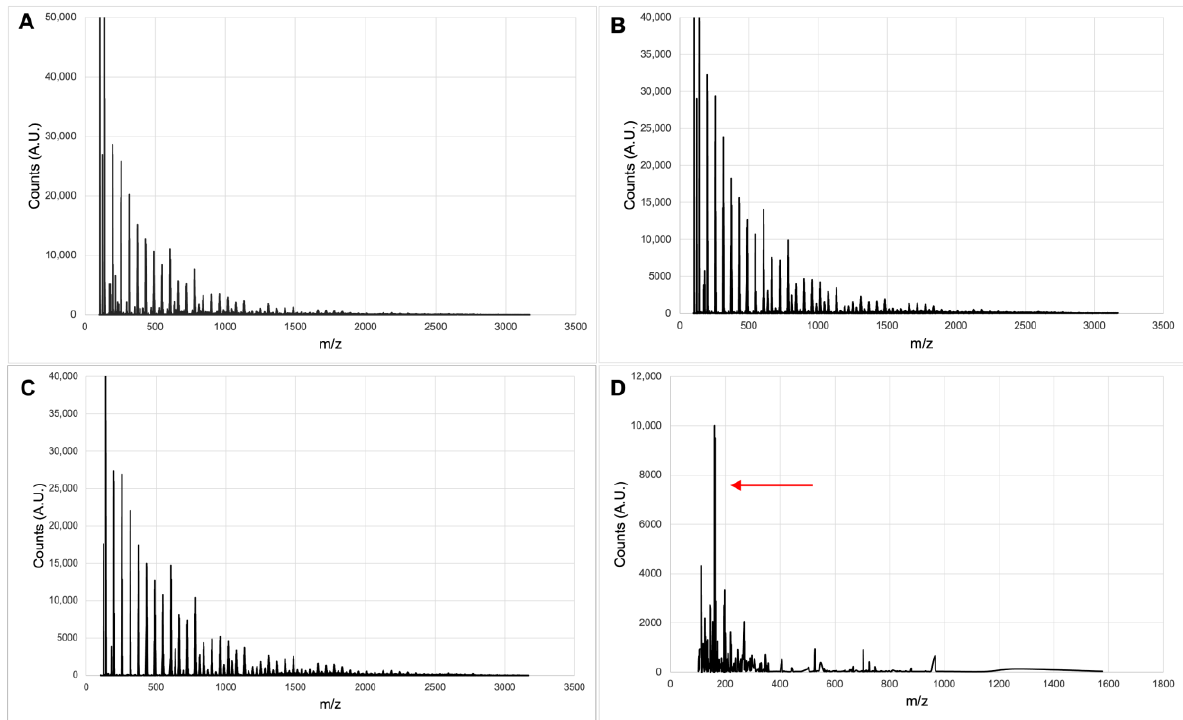
Figure 5. Electrospray ionization mass spectrometry of alginate samples digested with ( A ) 1 M HCl for 3 h, ( B ) 2 M HCl for 3 h, ( C ) 3 M HCl for 3 h, and ( D ) Alginate lyase for 24 h. The red arrow indicates signal at 158 m / z .